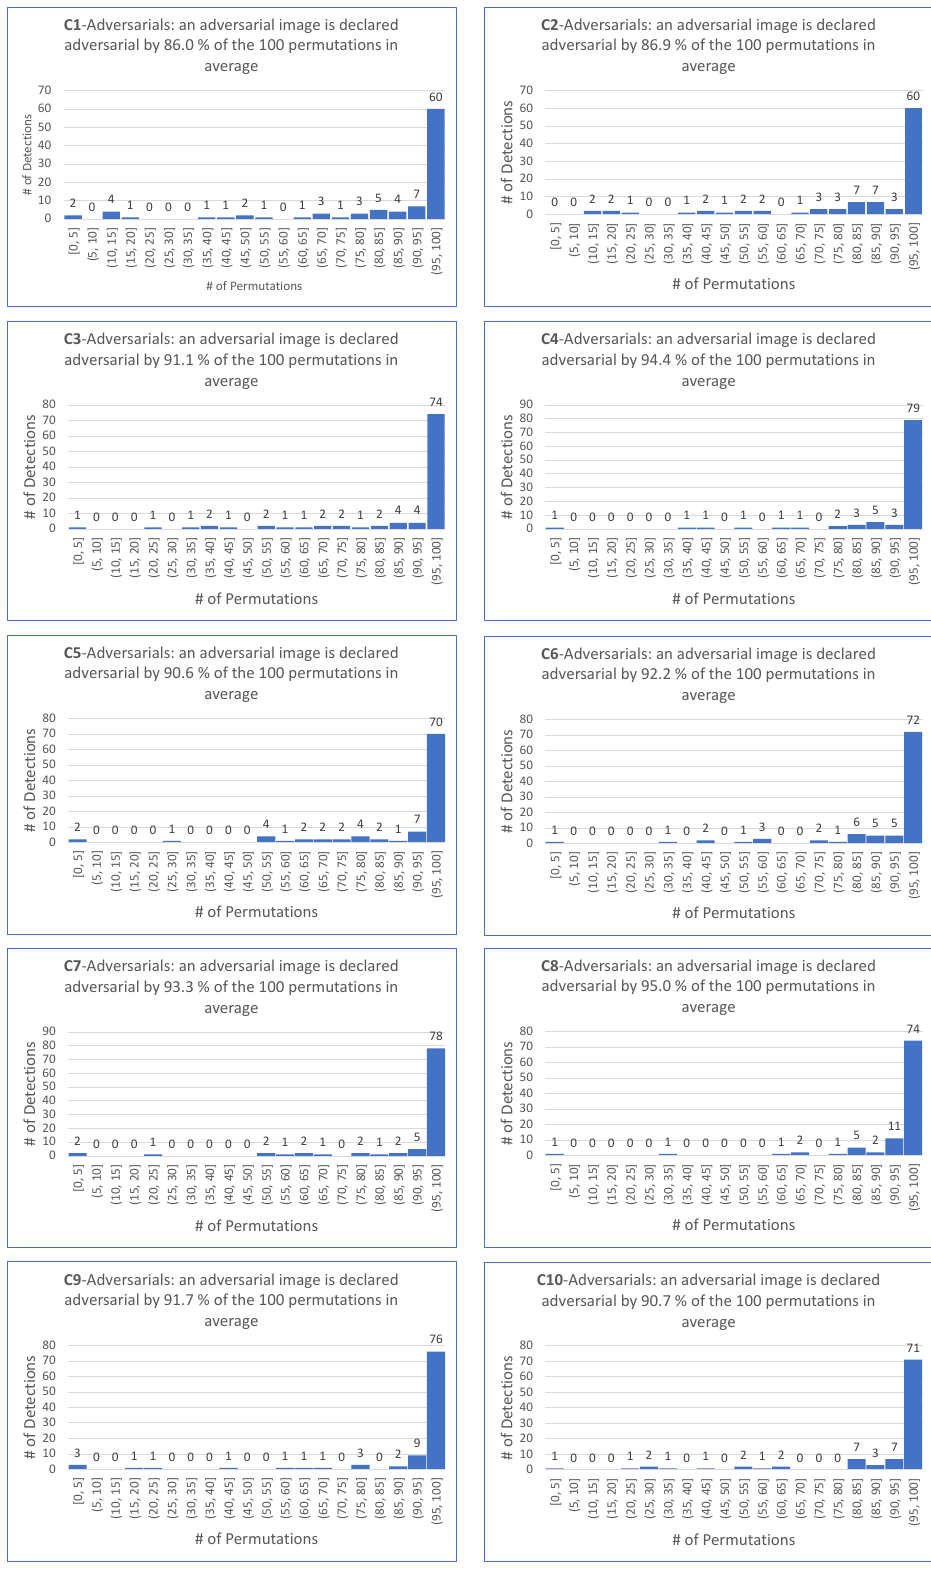
Figure A7. ShuffleDetect results for adversarial images generated by the EA-untargeted attack on C = C for 1 ≤ k ≤ 10 over 100